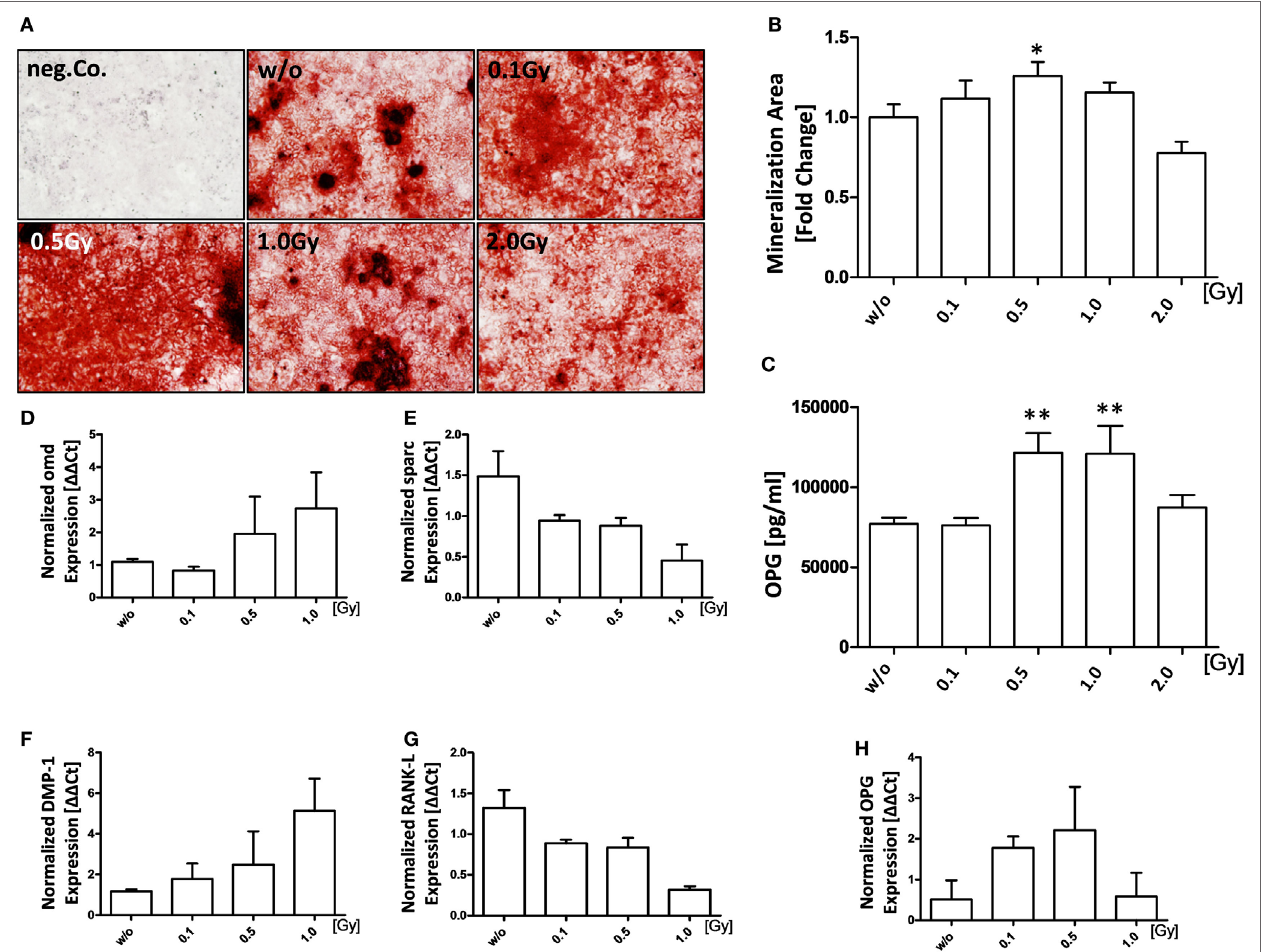
FigUre 3 | Low-dose irradiation increases mineralization properties of osteoblasts (OBs). Pre-osteoblasts (pOBs) were isolated from the calvariae from 3–6 days old neonatal h TNF- α tg mice. Cells were seeded and irradiated at d1 after the addition of mineralization media that was added after cells reached about 80–90% confluency. (a) Shows Alizarin red stains at d21; representative images were taken at 5 × magnification. Mineralization areas of full wells were quantified using ImageJ (B) . Supernatants from d7 were analyzed for OPG via enzyme-linked immunosorbent assays (c) . Total mRNA from d21 was isolated, the triplicates of each cell line were pooled and quantitative real-time PCR for selected OB markers was carried out (D–h) . Depicted is joint data from two independent experiments with three independently generated OB lines. Each experiment was carried out in triplicates. Data are presented as mean ± SEM and analyzed by two-tailed Mann– Whitney U test in comparison to mock-treated controls (w/o) (* p < 0.05 and ** p <